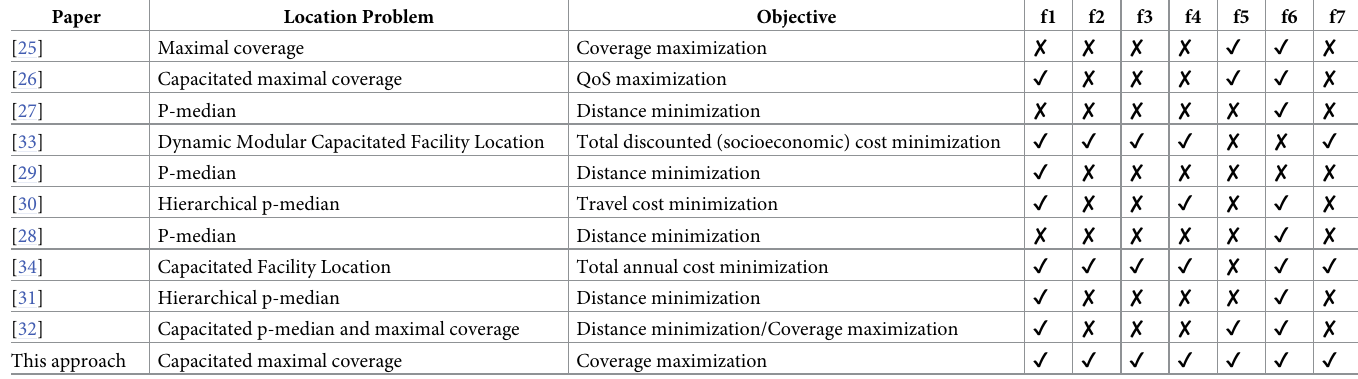
Table 1. Comparison of